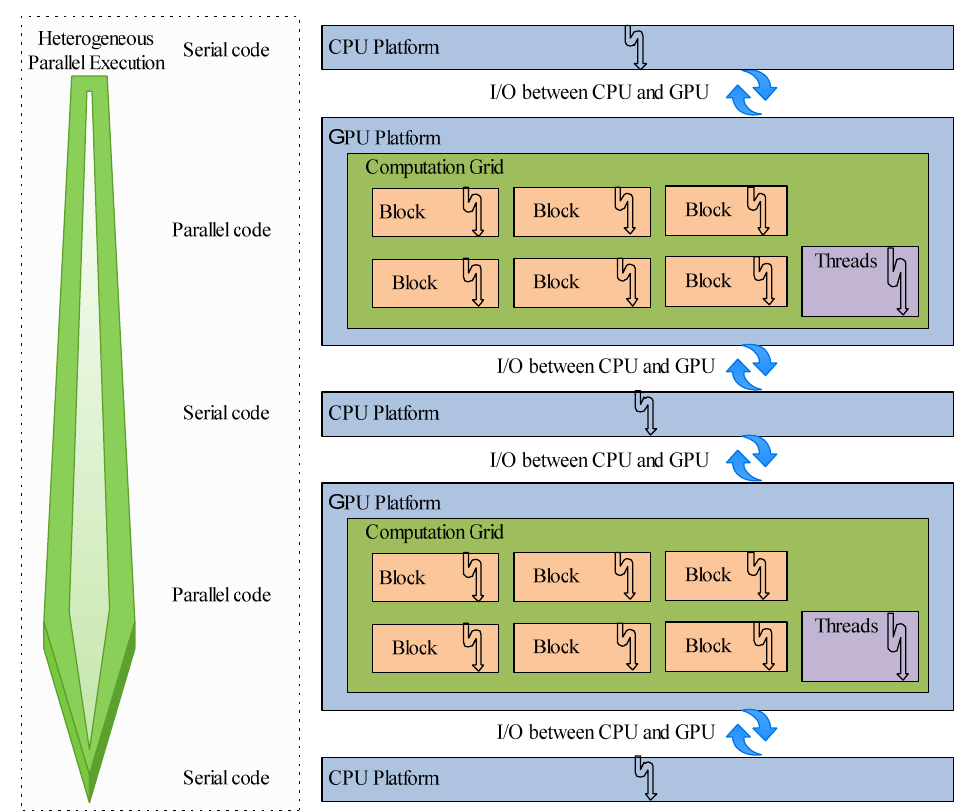
Figure 3. Heterogeneous parallel